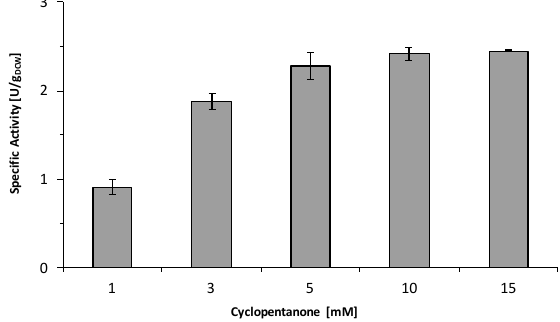
Figure 1. Biotransformation of 1f at different substrate concentrations by cells of Synechocystis sp. PCC6803 harboring CHMO under light of 300 µ E m − 2 and a cell concentration of 1.8